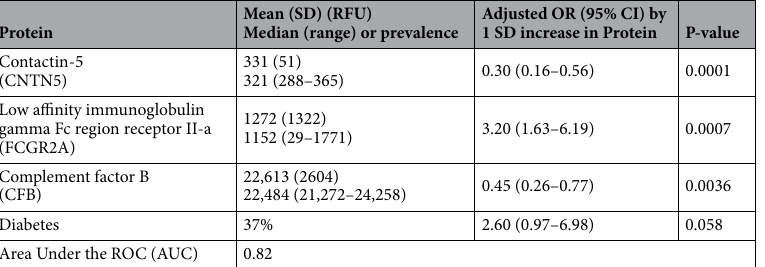
Table 3. Multivariable logistic regression modeling of effects of selected proteins on CVD incidence * . *This multivariable model was selected from the 36 proteins that were statistically significant in the univariable model. The baseline clinical model of variables from Table 1 only included diabetes. The final main-effects model reported here includes these three proteins and diabetes.